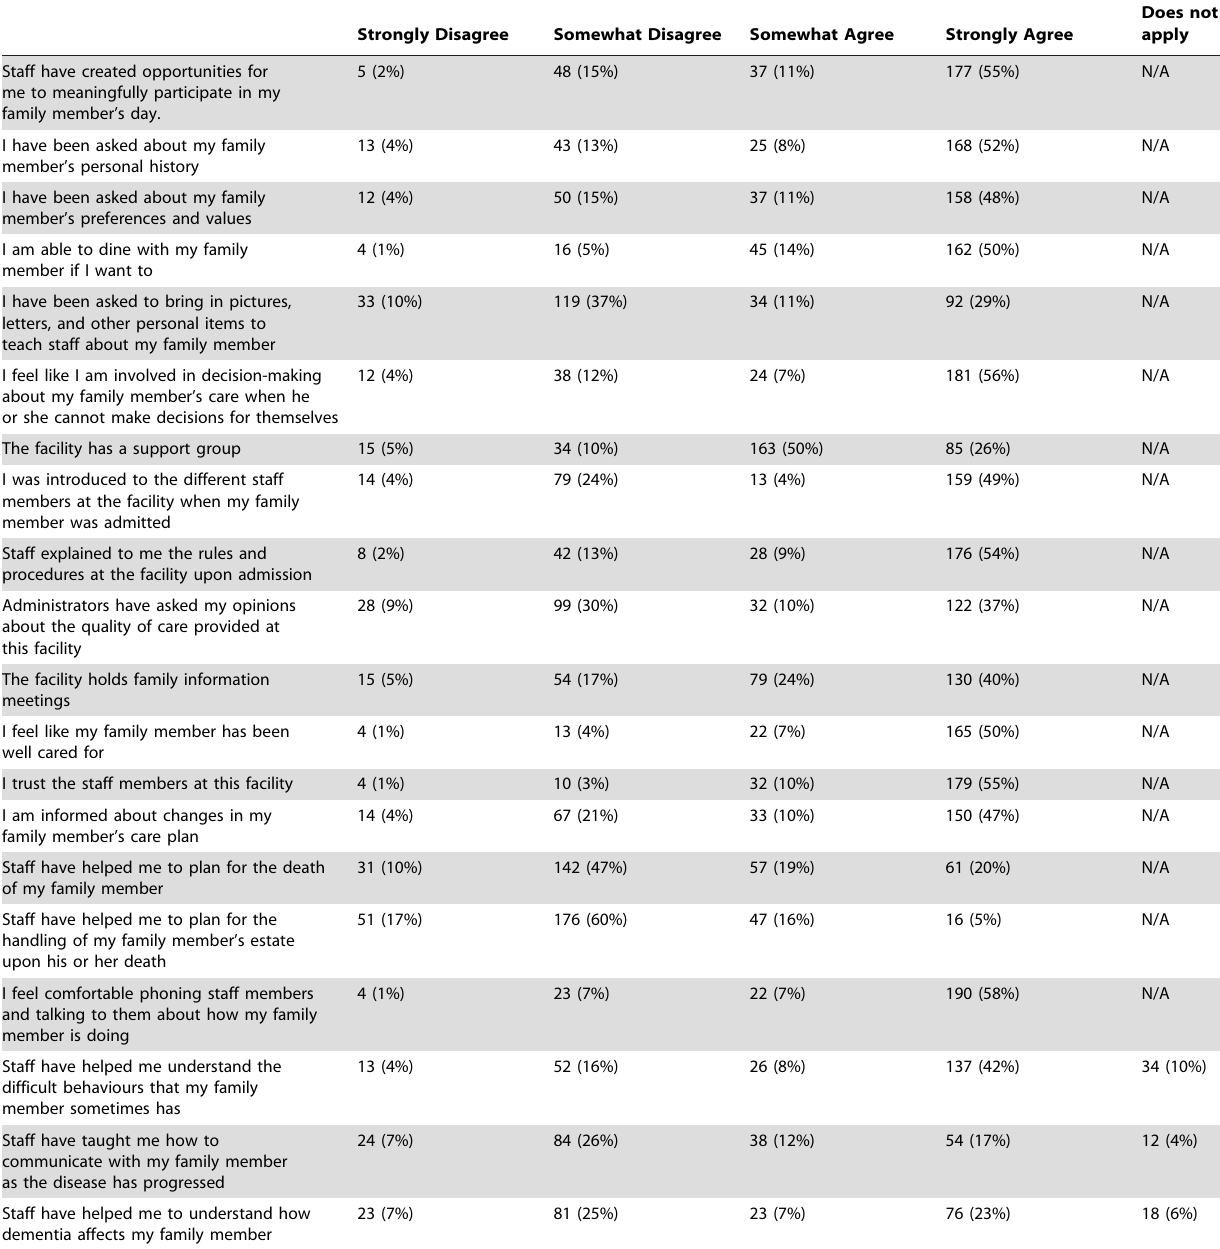
Table 2. F-involve